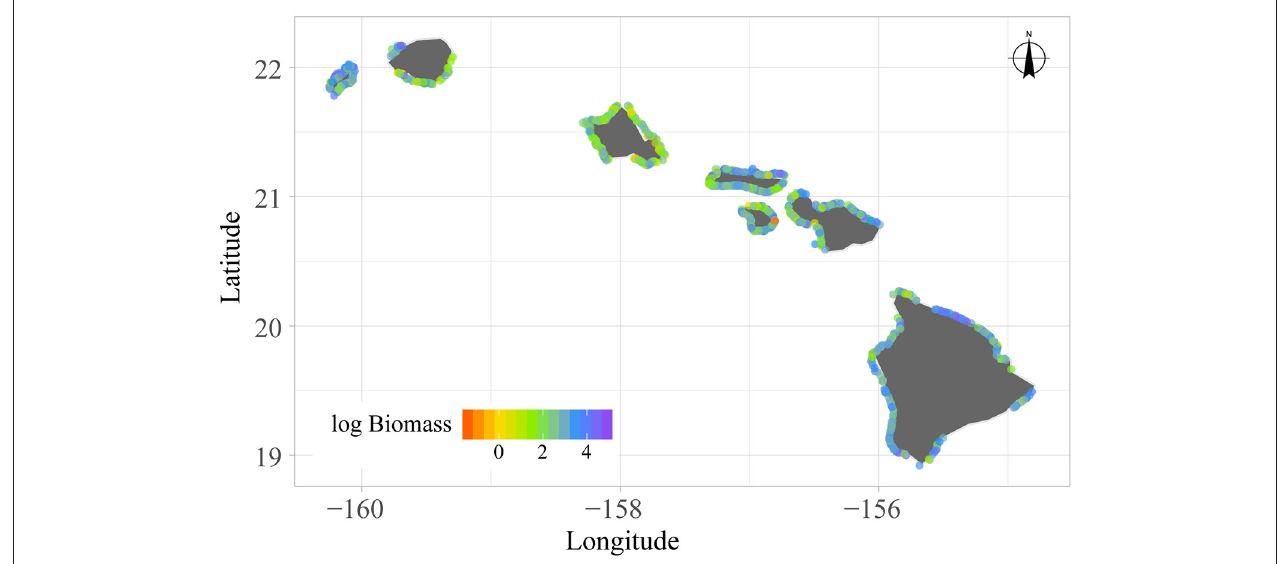
FIGURE 3 | In situ percent coral cover for 717 reef fish surveys conducted around the main Hawaiian Islands between 2012 and 2015.